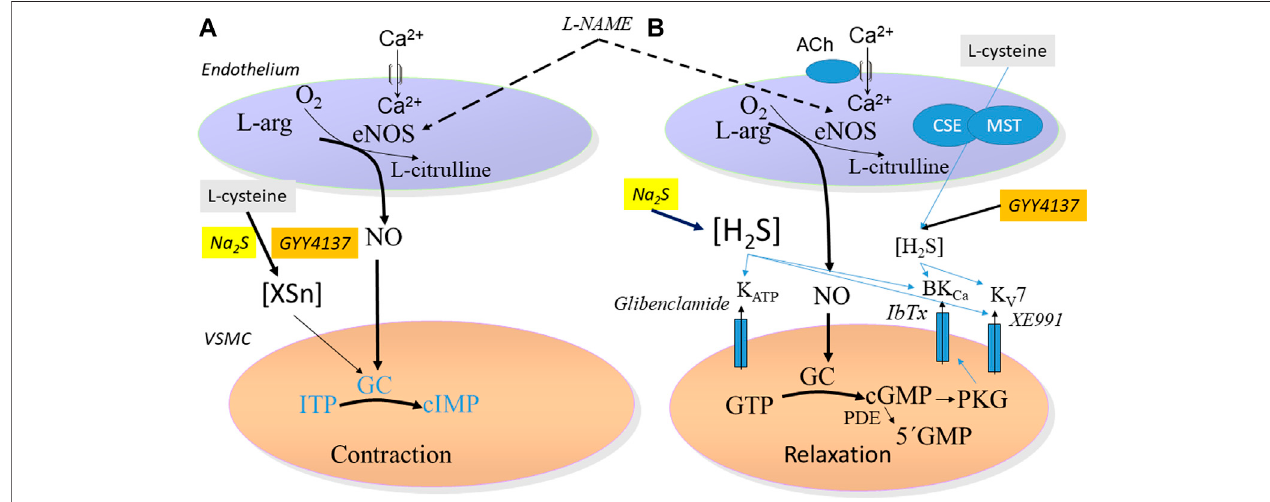
FIGURE9| Schematic fi gureproposingthemechanismsinvolvedin (A) contraction insmallmesenteric arteries inducedbyNa 2 Sand GYY4137 inthepresenceof L-cysteine. This involve a formation of a sul fi de product (XSn) that may modulate guanylate cyclase leading to contraction of the vascular smooth muscle cells (VSMC). TheeffectispartlyreversedbytheNOsynthaseinhibitor,L-NAME (B) RelaxationinducedbyNa 2 SandGYY4137leadsto,respectively,fastandslowreleaseofH 2 Sand followed by activation of subsets of different potassium channels: ATP-sensitive K (K ATP ) channels by Na 2 S, and of large-conductance calcium activated (BKCa) and voltage-gated type 7 (K V 7) channels by